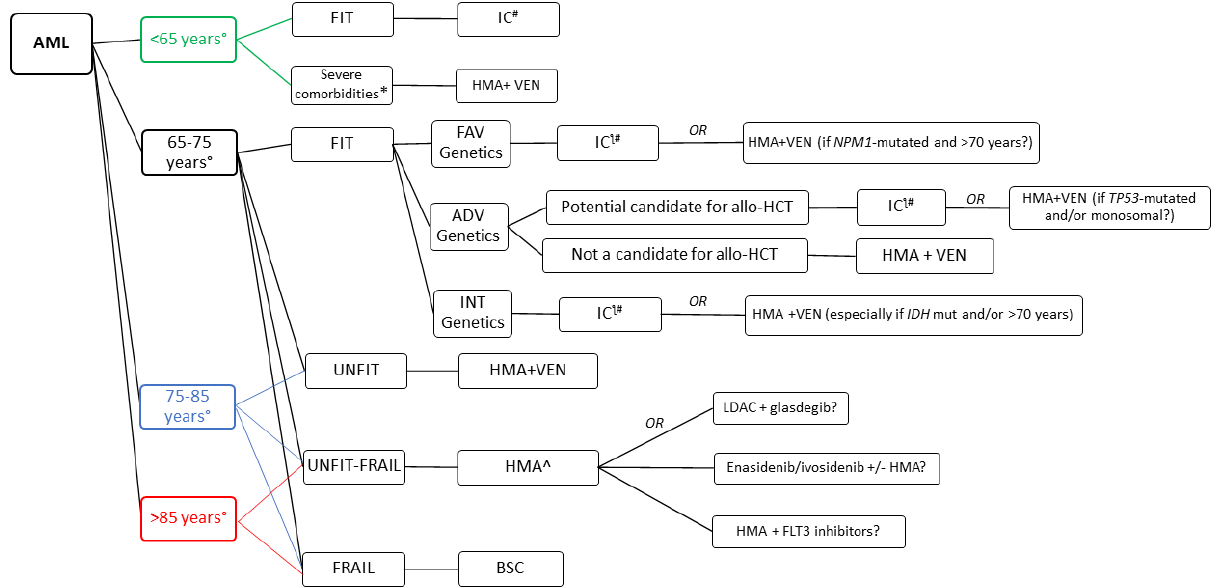
Figure 2. Treatment algorithm § of older AML patients that we follow in 2021. Abbreviations: Allo-HCT, allogeneic hematopoietic cell transplantation; ADV, adverse; BSC, best supportive care; FAV, favorable; HMA, hypomethylating agents; IC, intensive chemotherapy; INT, intermediate; LDAC, low-dose cytarabine; VEN, venetoclax. § The discussion regarding the type of consolidation or maintenance therapy is not included. ◦ Age cut-offs are somewhat arbitrary, and they are used to simplify the algorithm. They are never absolute. * In cases of moderate comorbidities, IC is usually preferred in this age group. In cases of significant cardiac comorbidity, a regimen without anthracycline can be considered (e.g., FLAG). # Intensive chemotherapy according to the disease profile (i.e., 7+3 and GO, 7+3 and midostaurin, CPX-351, FLAG-ida, 7+3). > Above 70 years of age, dose reductions are usually considered, such as 2+5 with midostaurin and a 4-day regimen of FLAI. CPX-351 is administered at full dose when employed. ˆ Especially when features predicting a good chance of response are present, such as non-proliferative